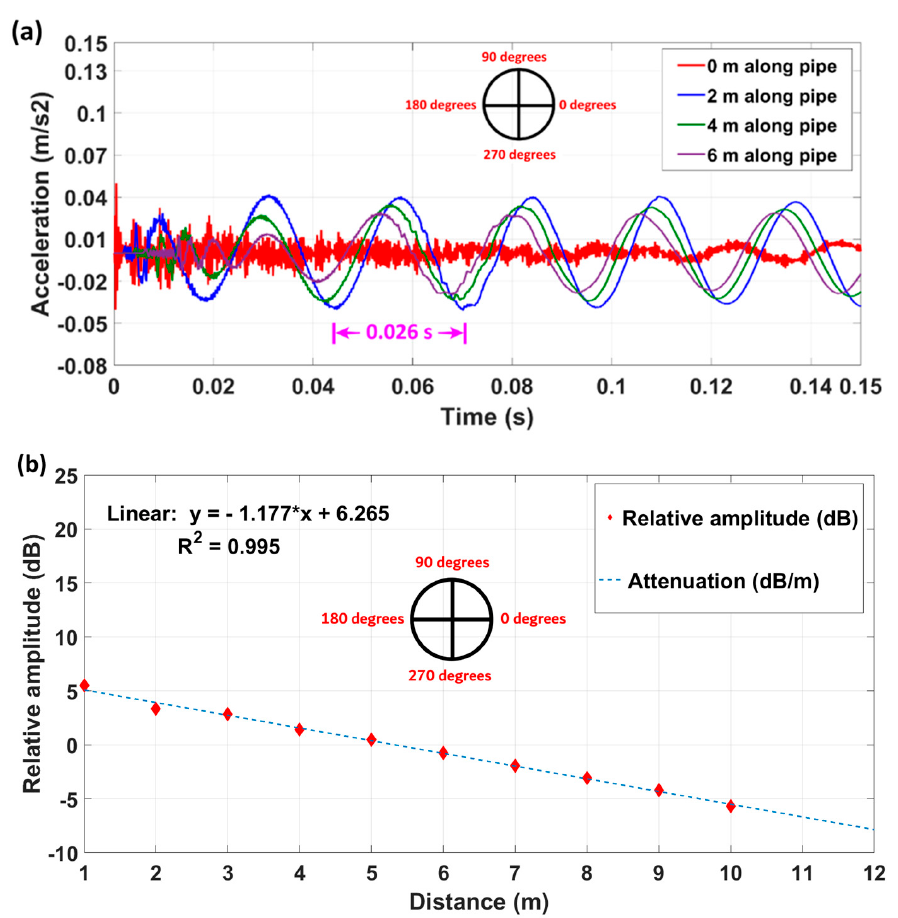
Figure 9. ( a ) Predicted time domain acoustic response and ( b ) predicted acoustic attenuation along the exposed MDPE pipe.